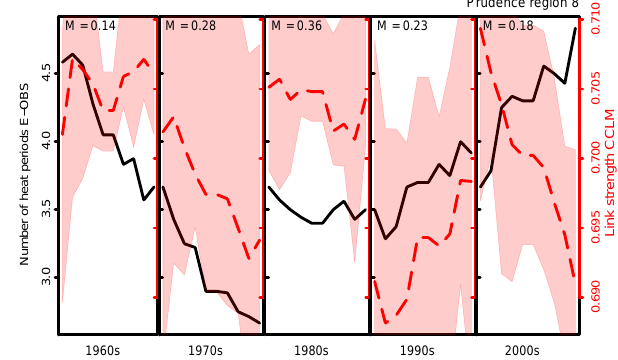
Figure 6. Number of heat periods (1961–2010) in Eastern Europe (Prudence 8) in summer from E-OBS o (black) and CCLM link strength or correlation threshold W (red: ensemble mean and in- terquartile range). The M’s denote the absolute mean difference within a decade between E-OBS and the CCLM ensemble mean after normalization (see Eq.